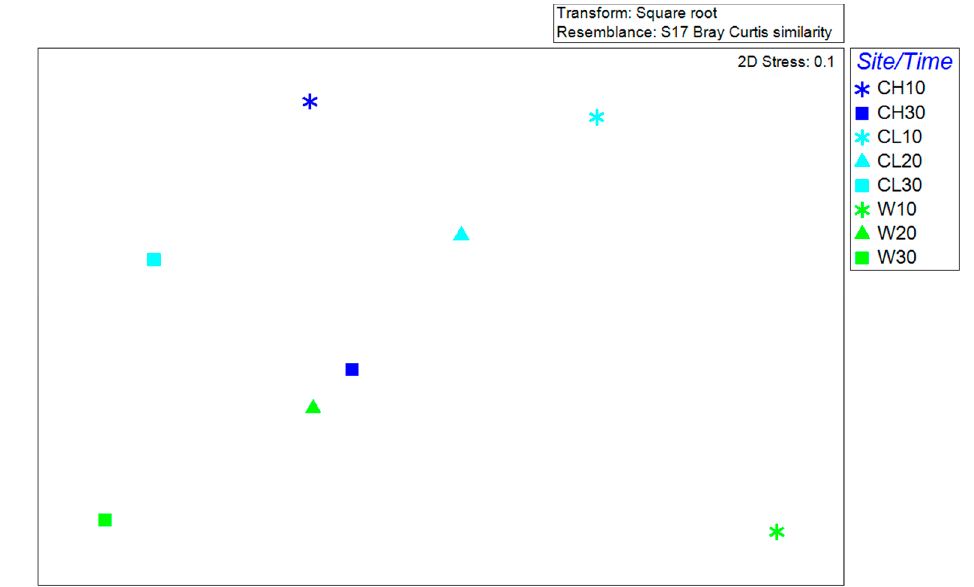
Figure 7. Non-metric multidimensional (nMDS) plot of eukaryotic communities. Each of CH10, CH30 indicates samples collected in Chilbolton at high elevation (range of 950 – 1000 m asl) in the time duration of 10 min and 30 min. Each of CL10, CL20, CL30, indicates samples collected in Chilbolton at low elevation (range of 300 – 450 m asl) in the time duration of 10 min, 20 min, and 30 min. Each of W10, W20, W30, indicates samples collected in Weybourne (height range of 650 – 1000 m) in the time duration of 10 min, 20 min, and 30 min.